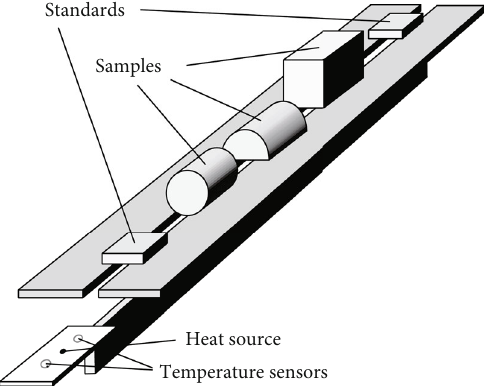
Figure 1: Schematic diagram of TCS